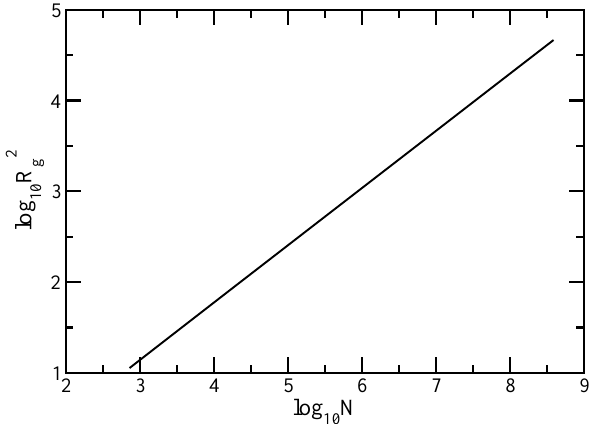
Figure 3. The mean-squared radius of gyration of the fractal cactus network calculated in the Rouse